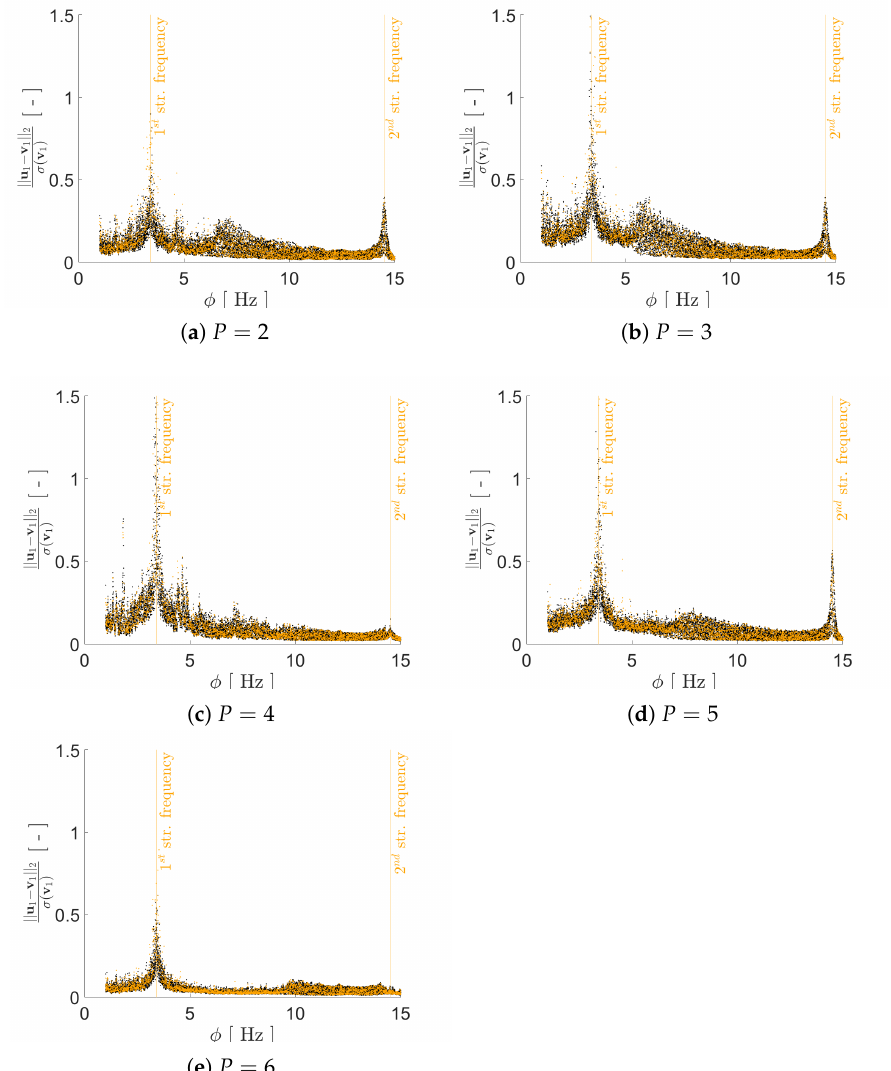
Figure 9. Two-storey shear building, configuration B. Reconstruction error for floor displacement v 1 via the standardized L 2 norm, as a function of the load frequency φ and for a varying value of P . In the charts, black dots refer to the training set, while orange dots refer to the validation